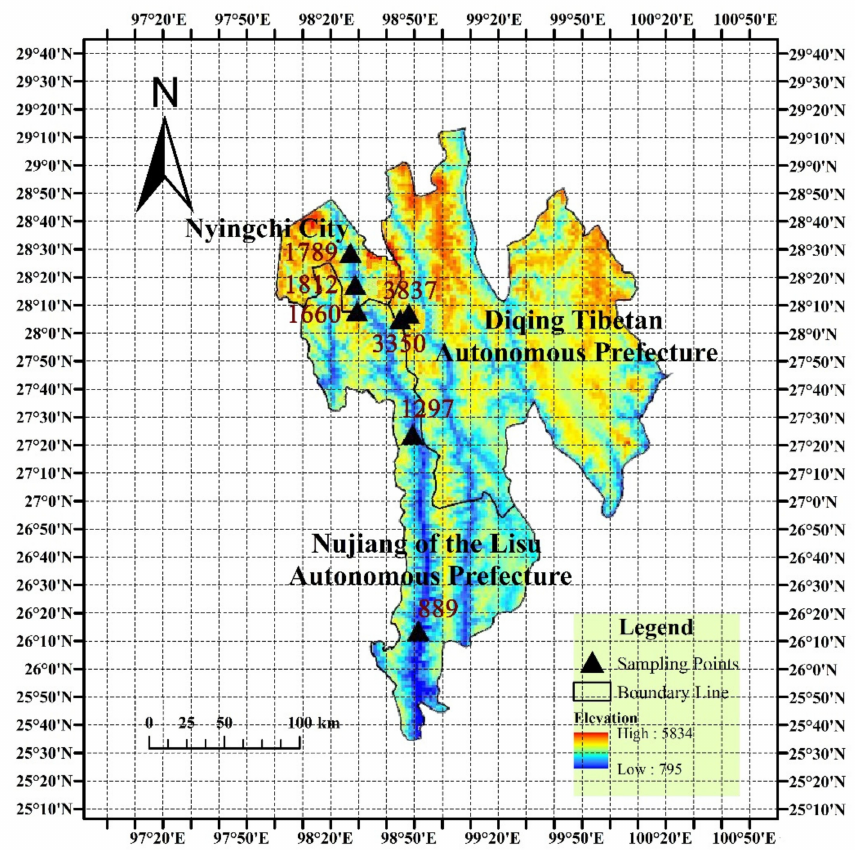
Figure 1. Location map of sampling sites in the Tibetan